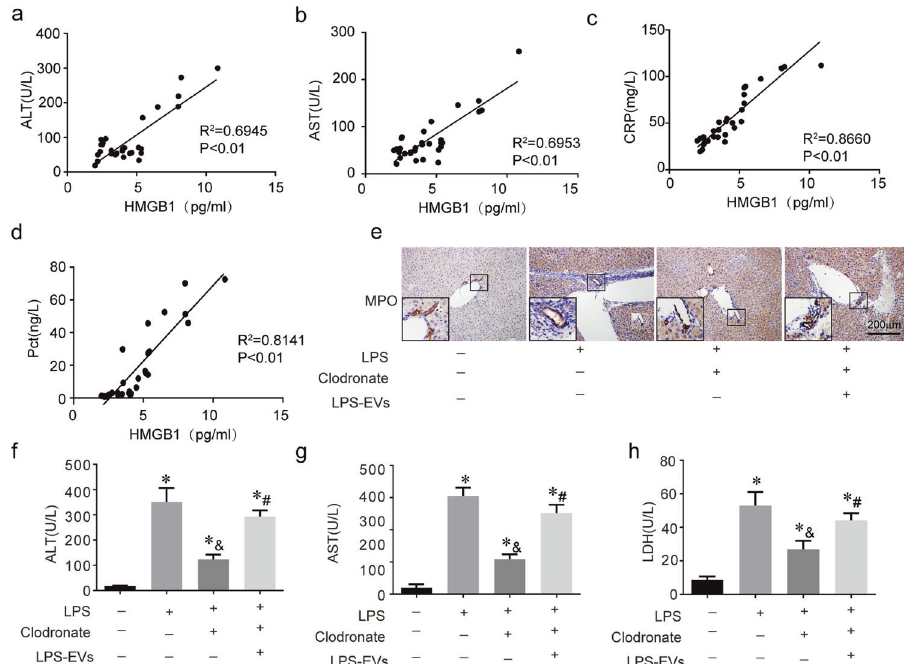
Fig. 2 LPS-induced macrophage EVs cause liver damage. a – d The EVs HMGB1 in sepsis patients serum were correlated with the levels of ALT (alanine aminotransferase), AST (aspartate aminotransferase), CRP (C-reactive protein), and Pct (procalcitonin). n = 5 mice per group. e MPO (myeloperoxidase) staining in the liver of all groups; Scale bar = 200 μ m. f – h Serum ALT, AST and LDH (lactate dehydrogenase) levels in all groups. n = 5 mice per group. (*) P < 0.01 versus control group; ( & ) P < 0.01 versus LPS group; ( # ) P < 0.01 versus clodronate